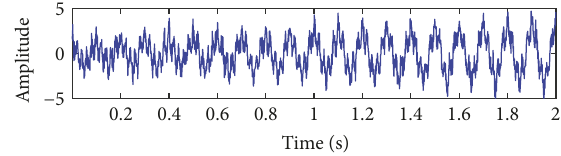
Figure 10: Time-domain waveform of the composite signal